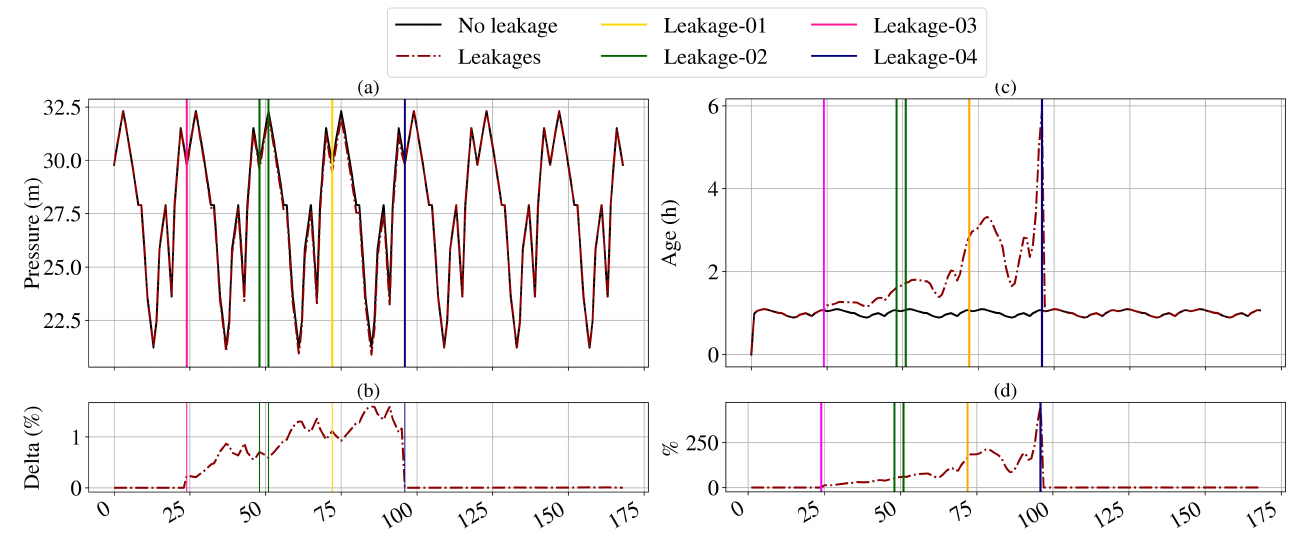
Figure 5. Sensitivity of node 187 for leaks in scenario B: ( a ) Pressure variation, ( b ) Pressure variation delta, ( c ) Quality variation and ( d ) Quality variation